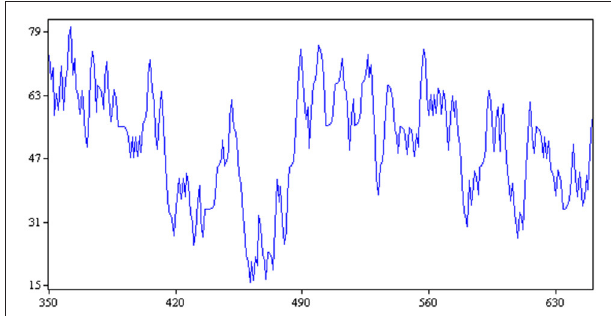
FIGURE 8 | Timeplot obtained with the same values of the parameters of Figure 6 and initial condition P 0 = 54.